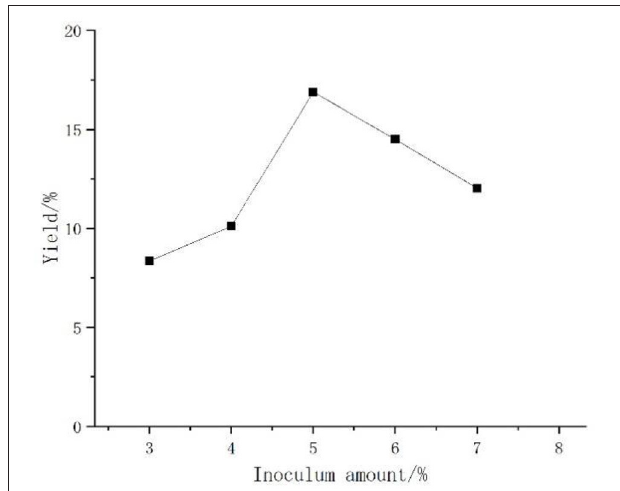
FIGURE 1 | Effect of Aspergillus niger inoculum on the yield of Artemisia